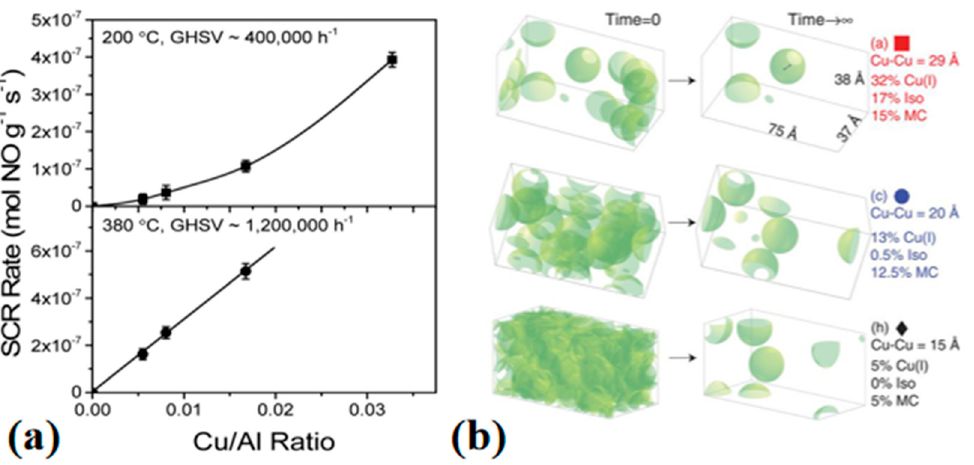
Figure 11. ( a ) SCR rate versus Cu/Al ratio results obtained at two reaction temperatures: 200 °C (upper panel) and 380 °C (lower panel). Reproduced with permission from [57], copyright American Chemical Society, 2017. ( b ) Snapshots taken from simulated initial (time = 0) and final (time → ∞ ) Cu + spatial distributions for three Cu-SSZ-13 samples with different compositions: reproduced with permission from [56], copyright American Association for the Advancement of Science, 2017.